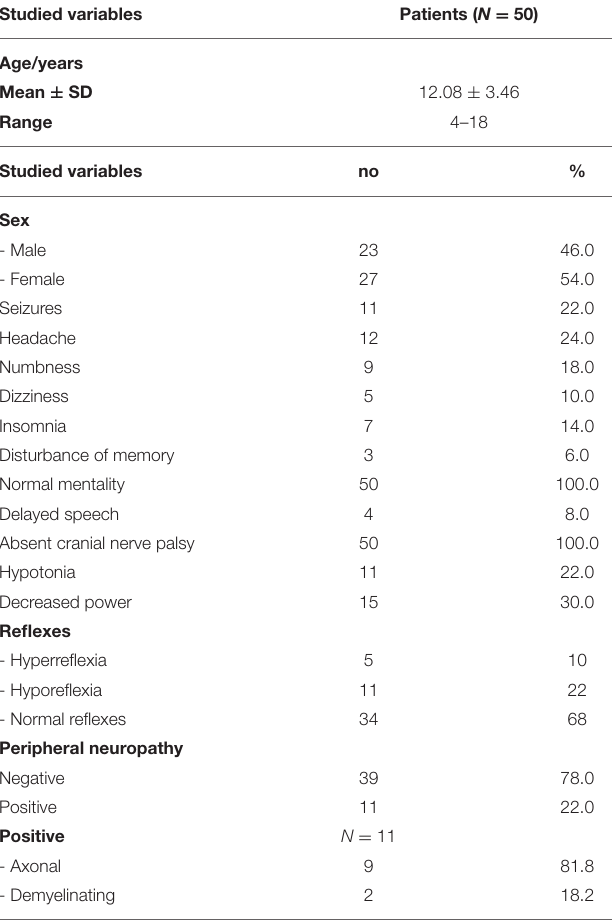
TABLE 1 | Distribution of demographic, clinical, and neurological examinations in patients with CKD. Studied variables Patients ( N =